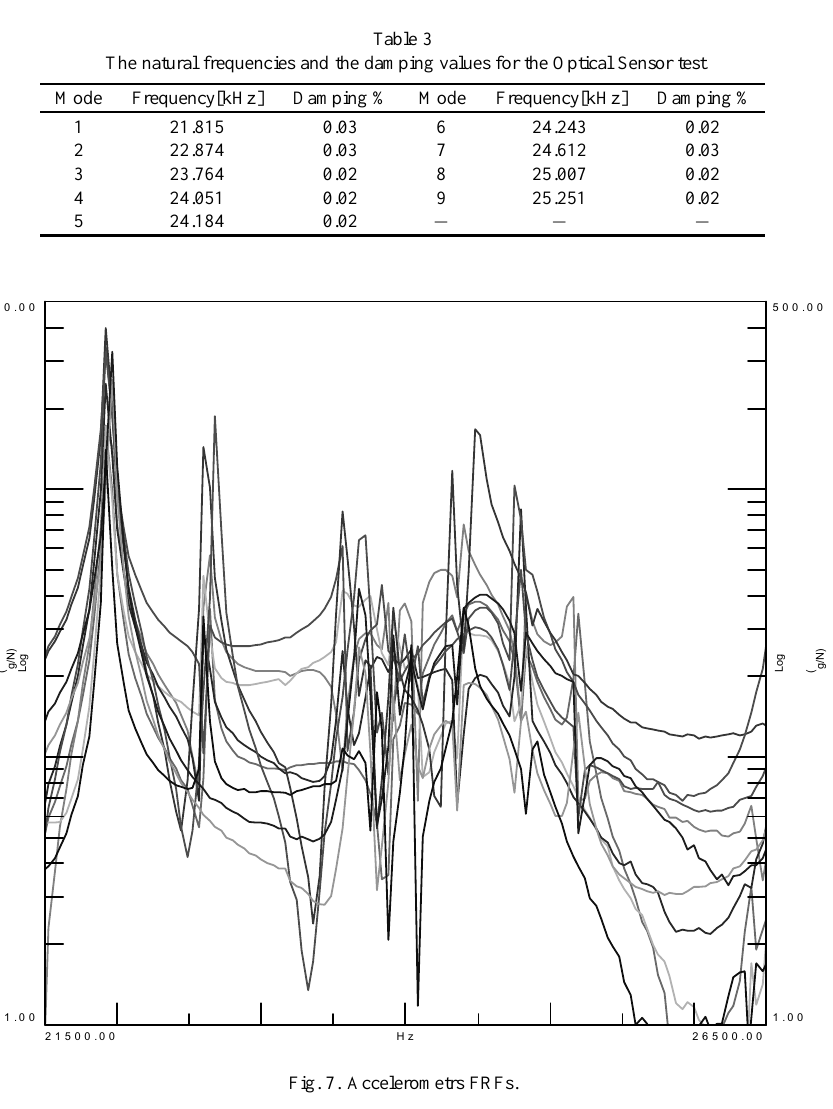
Fig. 7. Accelerometrs